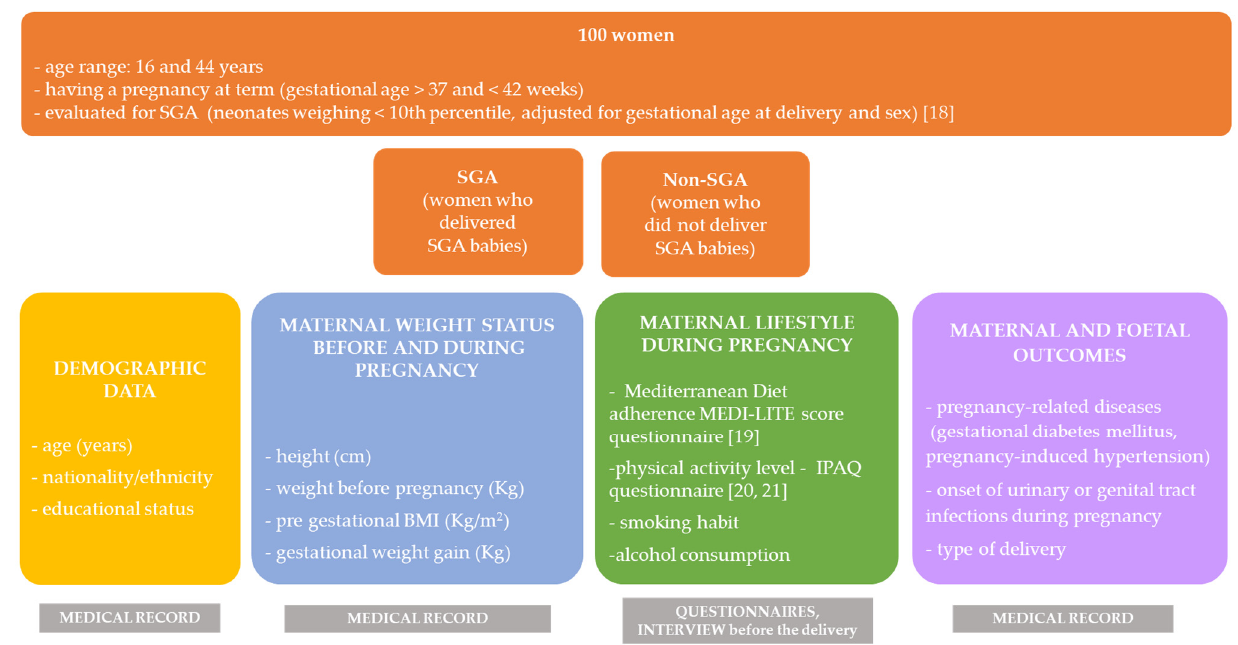
Figure 1. Study population and variables collected. Legend. BMI: body mass index; SGA: small for gestational age.